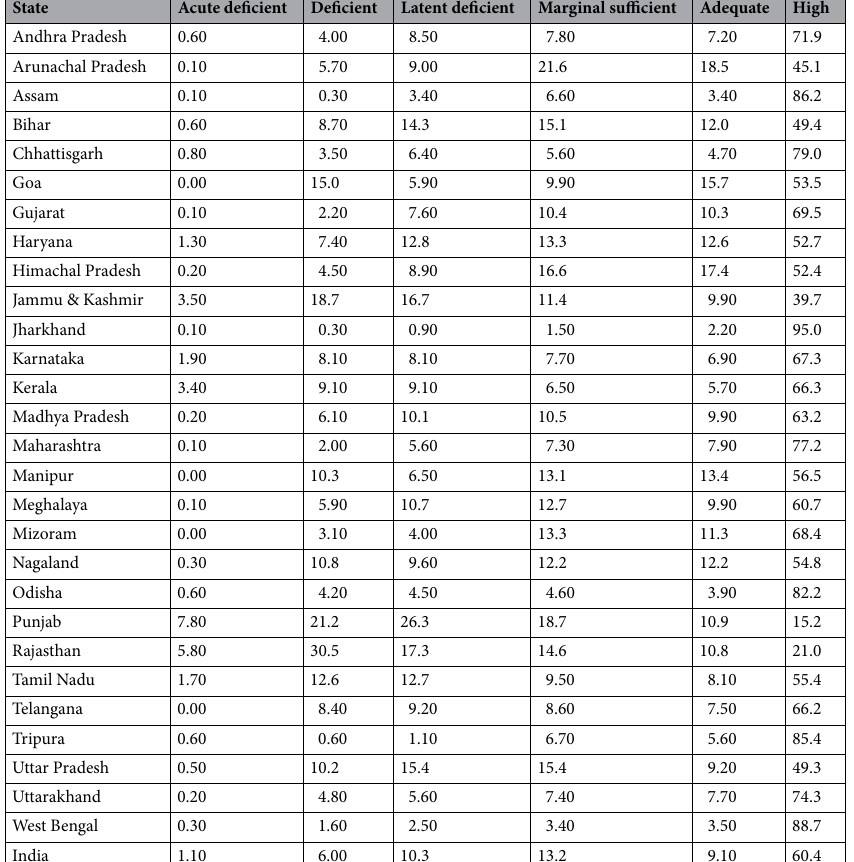
Table 7. State-wise deficiency (% of soil samples) status of available